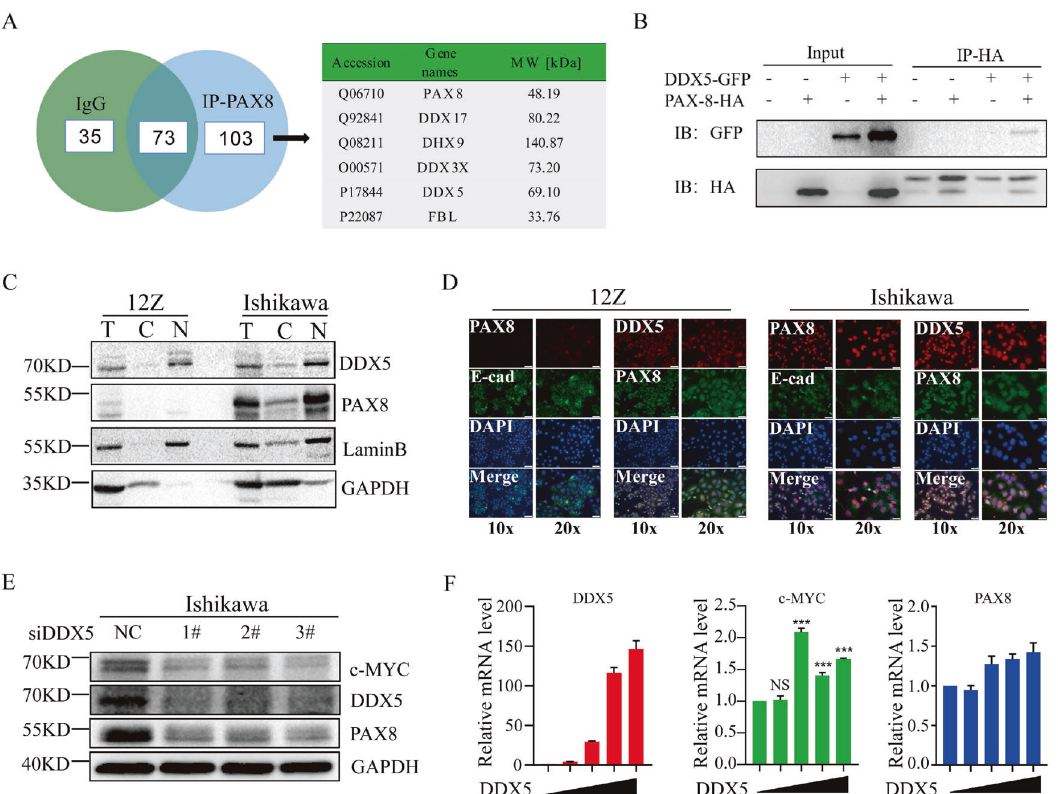
Fig. 5 DDX5 is a partner of PAX8. A PAX8-interacting proteins in Ishikawa cell were precipitated by using anti-PAX8 antibody, and identi fi ed by LC-MS/MS analyses. The proteins identi fi ed only in PAX8 precipitates are listed. B Co-IP analyses of HA-PAX8 and DDX5-GFP interaction in HEK293 cells. C Western analyses of the nuclear and cytoplasmic fractionated samples from 12Z and Ishikawa cells. Lamin B and tubulin were used as the nuclear (N) and cytoplasmic (C) markers, respectively. D Immuno fl uorescence was used to determine the localization of PAX8 and DDX5 in 12Z and Ishikawa cells. DAPI staining was included to visualize the cell nucleus (Blue). Scale bar = 200 μ m in 100x and 100 μ m in 200x vision. E PAX8 was knocked down in Ishikawa cells by using siRNA, after 48 h transfection, total protein was extracted from cells for Western blot analysis. F Gradient transfection of DDX5 plasmid in 12z cells, 24 h later, RNA was extracted to detect the expression of DDX5, c-MYC, and PAX8, Hprt was used as a housekeeping